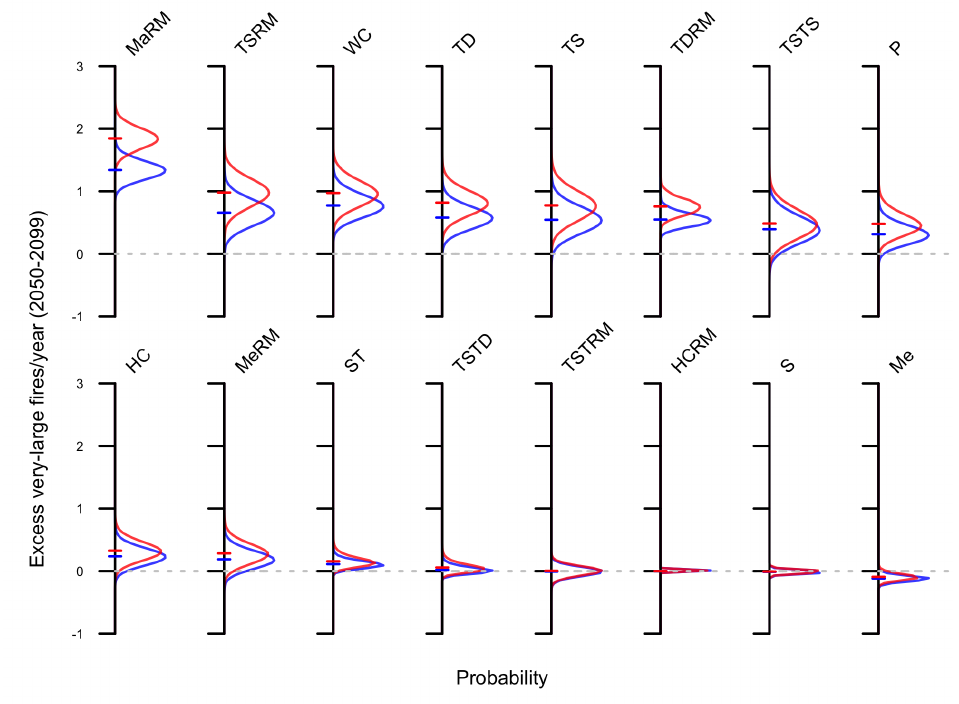
Figure 4. Kernel density estimates of the posterior and mean of the number of additional very-large fires per year relative to the 1956–2005 reference period per year by ecoregion under the representative concentration pathway (RCP) 4.5 (blue) and RCP 8.5 (red) scenarios arranged by magnitude of change. The excess very-large fire frequency is calculated by randomly sampling ( n = 10 6 ) from the posterior of historical (1956–2005) and future (2050–2099) multi-model averages and calculating the difference. Future changes in VLF frequency may or may not be uniformly distributed throughout the